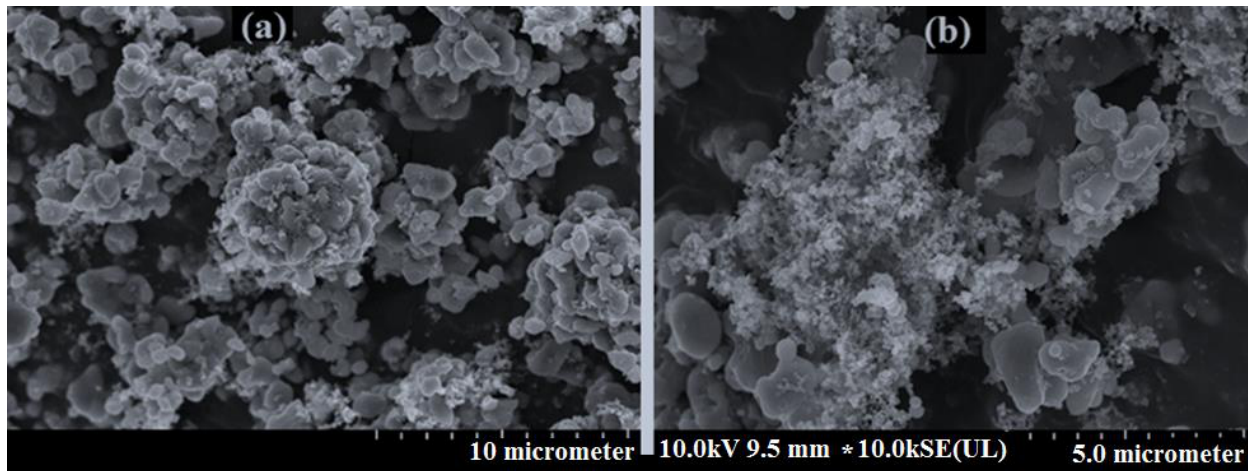
Figure 1. The SEM of two cathode materials for two samples including ( a ) = sample 21 = LiFe 0.890 Ti 0.055 Co 0.055 PO 4 , ( b ) = sample 16 = Li 1.835 Fe 0.055 Ti 0.055 Co 0.055 Mn 0.835 PO 4 .